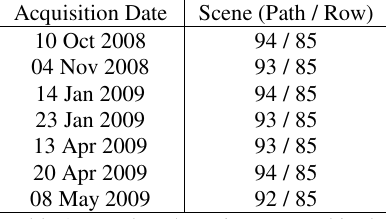
Table 1. Landsat 5 TM images used in the study.